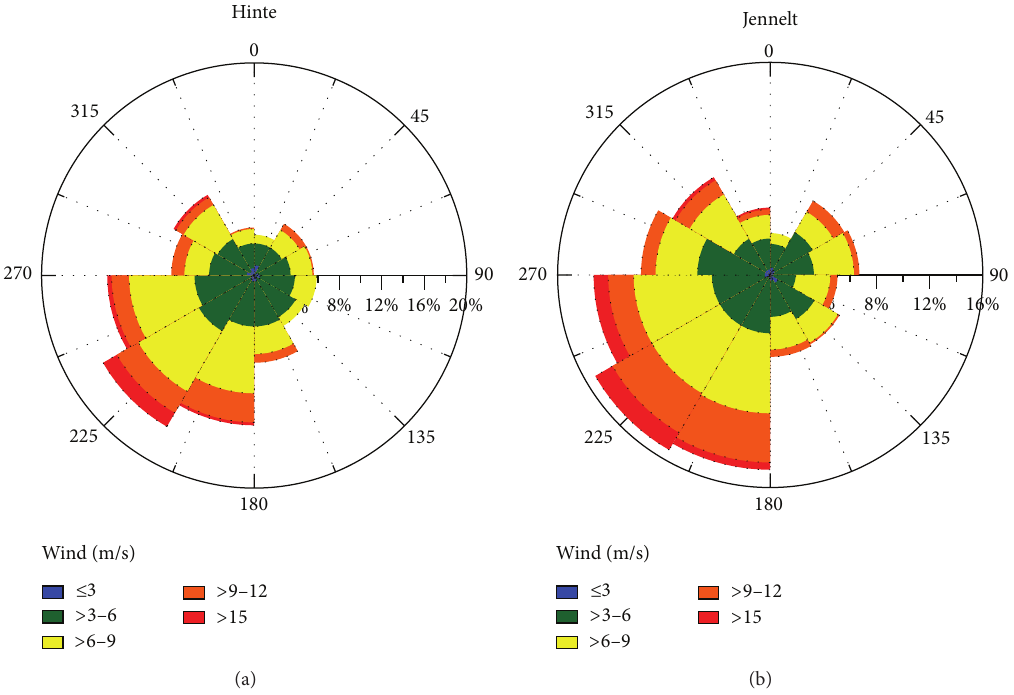
Figure 2: Average wind conditions at the coastal sites in Hinte (target site) and Jennelt (input site) during the observation period from January 2006 to January 2008.